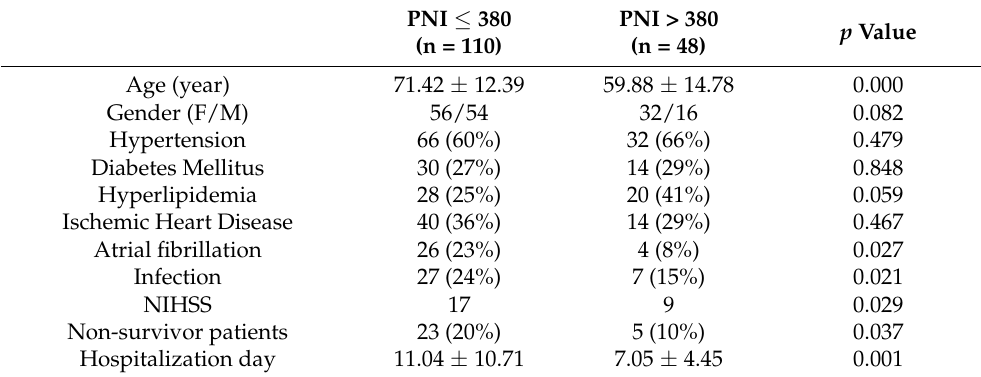
Table 1. Clinical characteristics of patients.